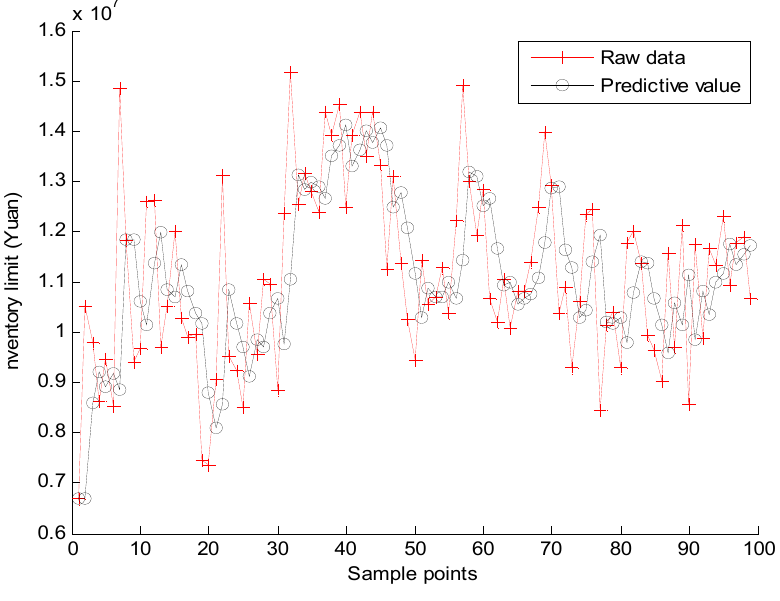
Figure 6. Predictive results of the first exponential smoothing prediction method in 2011.